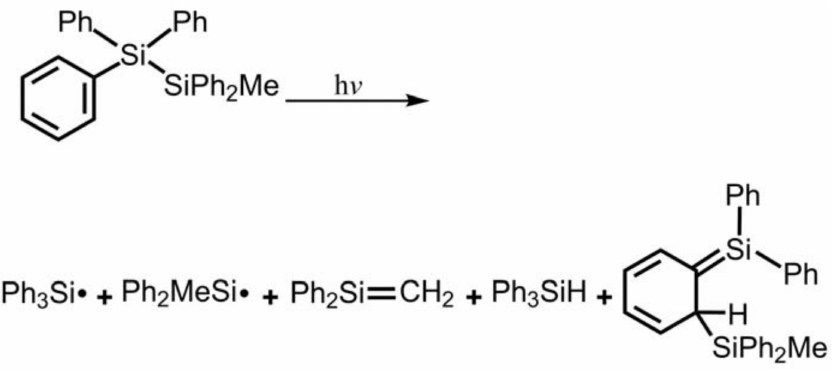
Scheme 1. The photochemical reactions of